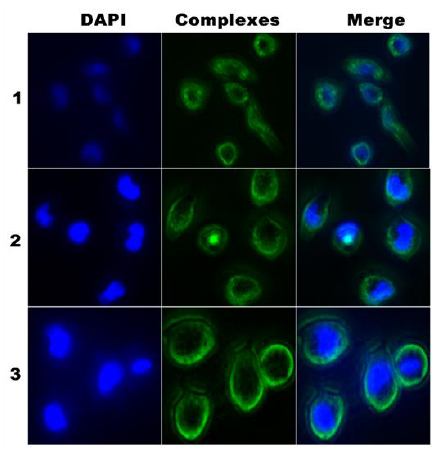
Figure 2. Cell uptake assay after SGC-7901 cells were treated with 4.0 µM 1 , 15.0 µM 2 and 15.0 µM 3 for 3 h.